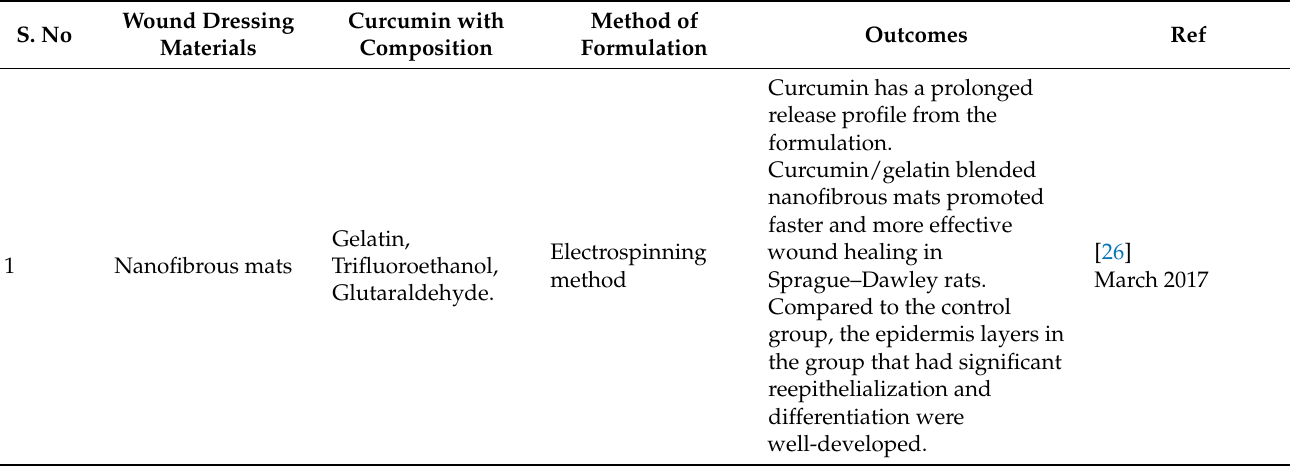
Table 1. A summary of available curcumin-based wound dressing products and their